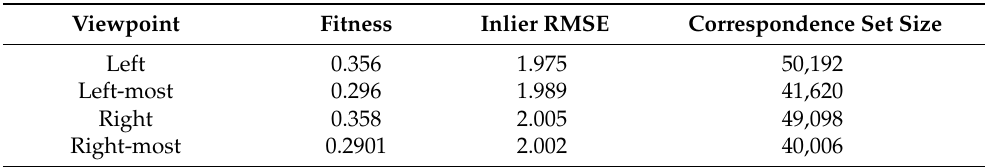
Table 3. The refined local registration errors of the listed source point clouds (side views) to the target camera position